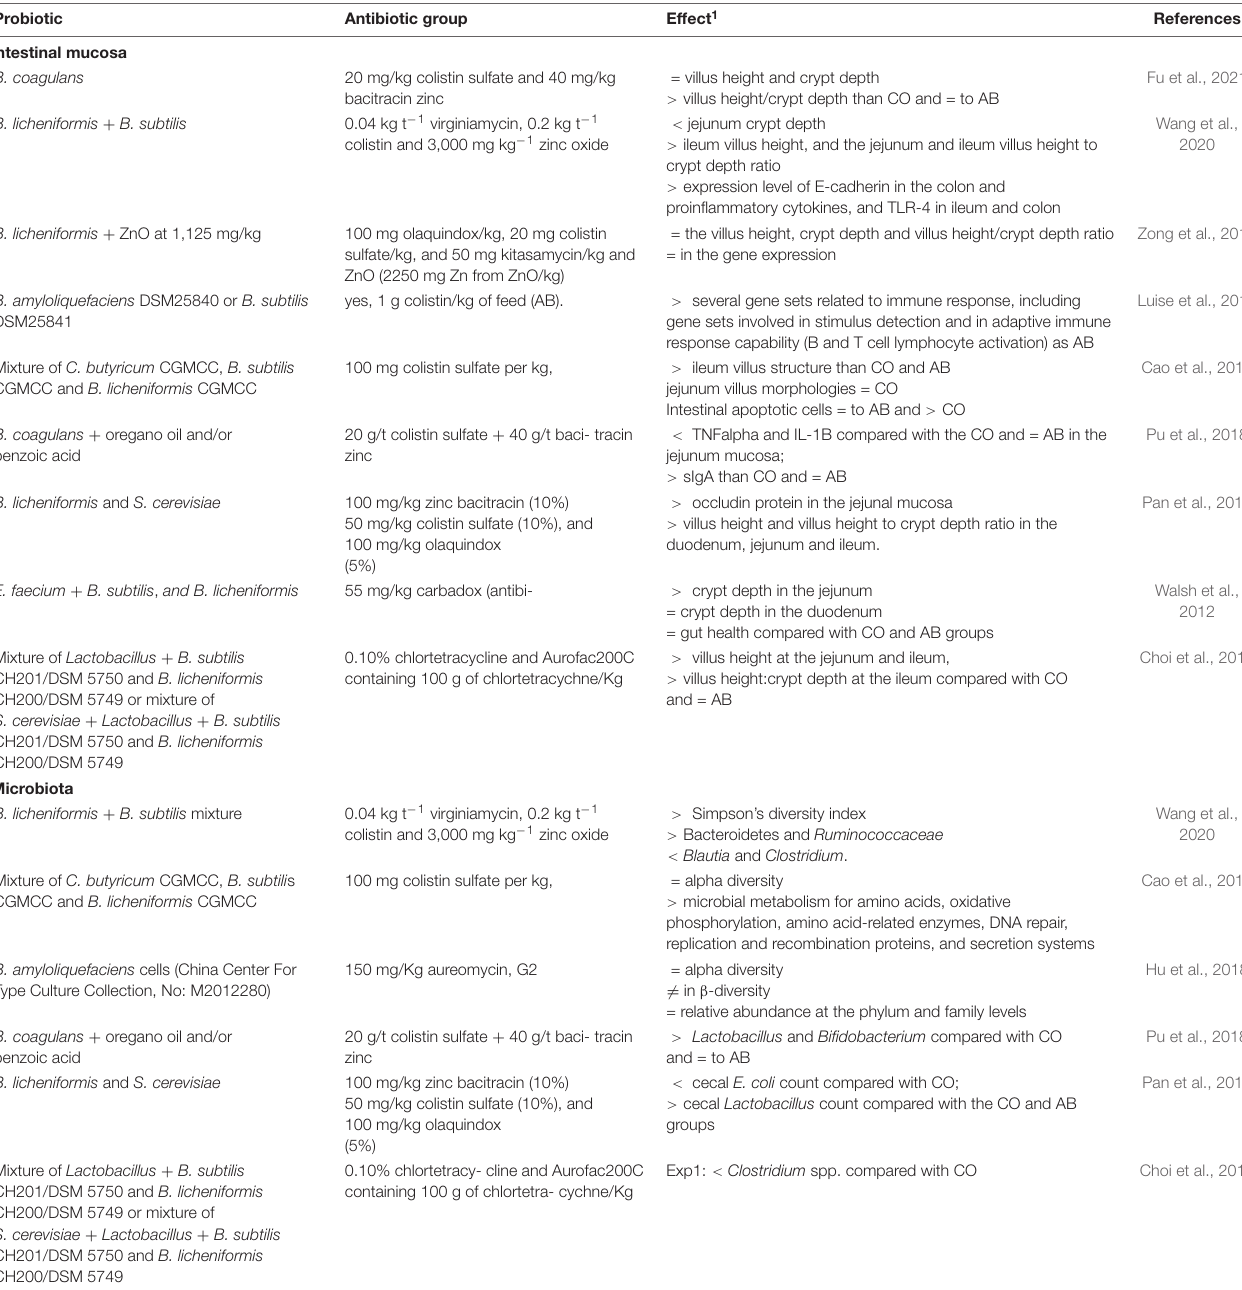
TABLE 1 | The effect of Bacillus probiotics on the intestinal mucosa and gut microbiota of post-weaning piglets as compared with antibiotic use.